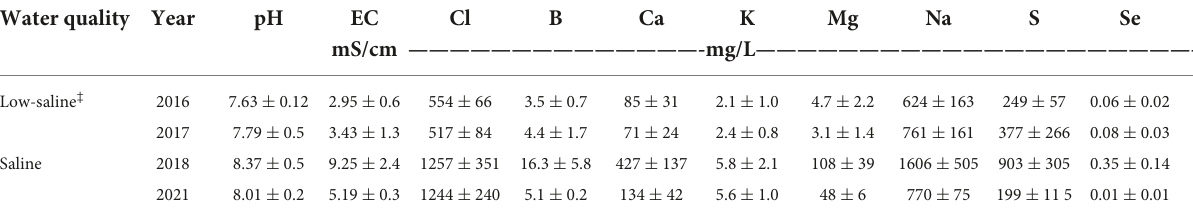
TABLE 3 Chemical characteristics of low-saline water and saline water applied to microplots for growing seasons in 2016, 2017, 2018, and 2021, respectively. Values represent average ( n = 3) ± SD of water samples collected through respective growing season. Water quality